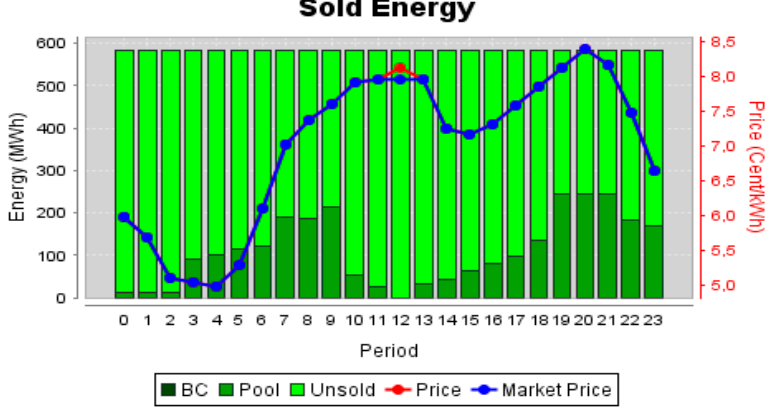
Table 4. Energy trade values.